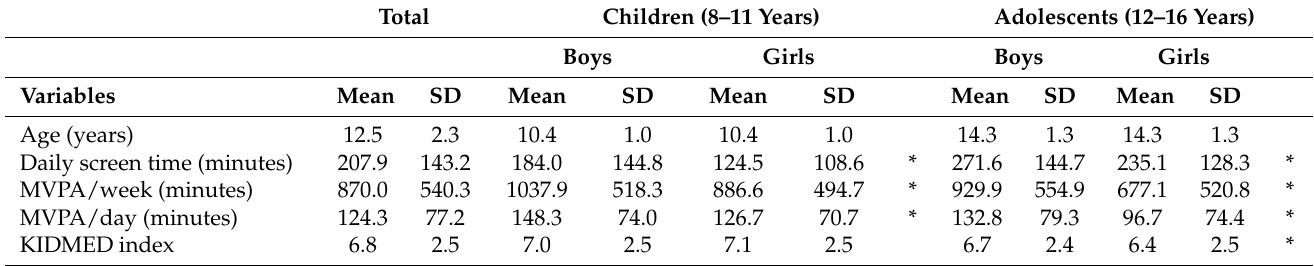
Table 3. Characteristics of study participants: age, screen time, physical activity, and KIDMED index for the total study population and according to sex.